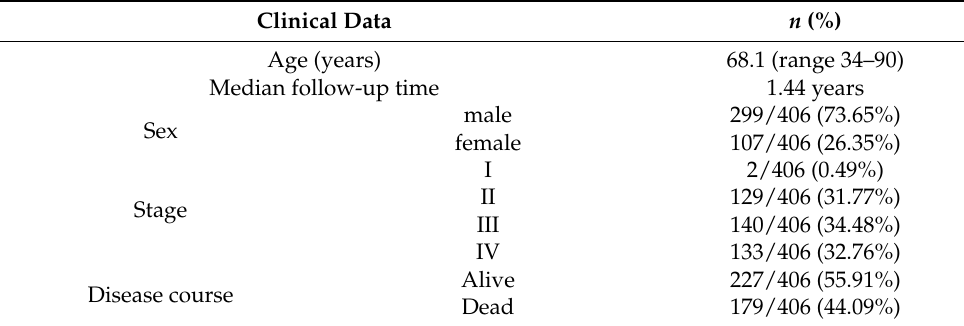
Table 4. Baseline characteristics of TGCA ( n = 406)